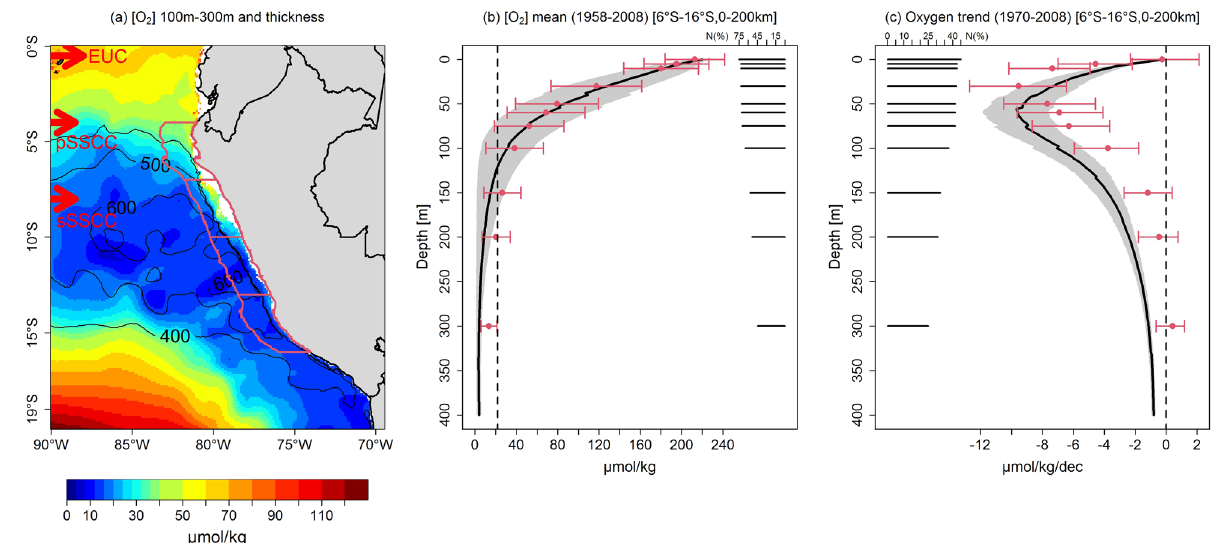
Figure 1. Dissolved oxygen mean state and trends off Peru. ( a ) Mean observed DO concentration (in µmol kg −1 ; color shading) and OMZ thickness (in meters; black contours); ( b ) mean observed (red dots) and modeled (black line) DO (in µmol kg −1 ) in a coastal band of 200 km, between 6° and 16° S; ( c ) DO linear trend (in µmol kg −1 dec −1 ) computed over 1970–2008 from IMARPE data (red dots) and model output (black line) at different depth levels. Black horizontal bars indicate the percentage of months with observations with respect to the total number of months (468) in the 1970–2008 period for each depth (right side of ( b ) and left side of ( c )). Red bars and grey shading in ( b ) and ( c ) indicate error bars for the observed and model values, respectively. The figures were generated using the software R (R Core Team, version 4.1.1., http:// www.R- proje ct.